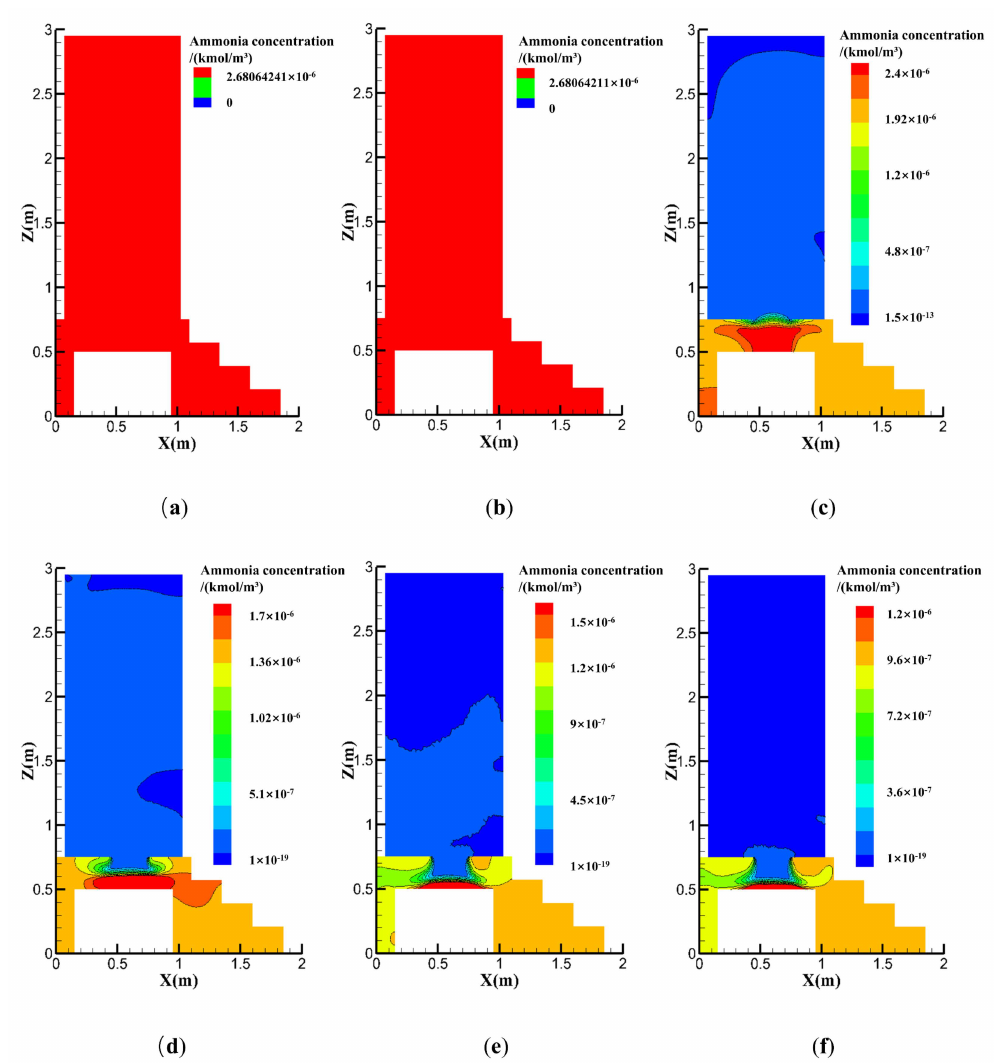
Figure 12. Ammonia concentration distributions for different ACH (unit: h − 1 ) values (EFP-F 1 ). ( a ): ACH = 0; ( b ): ACH = 2; ( c ): ACH = 4; ( d ): ACH = 6; ( e ): ACH = 8; ( f ): ACH =